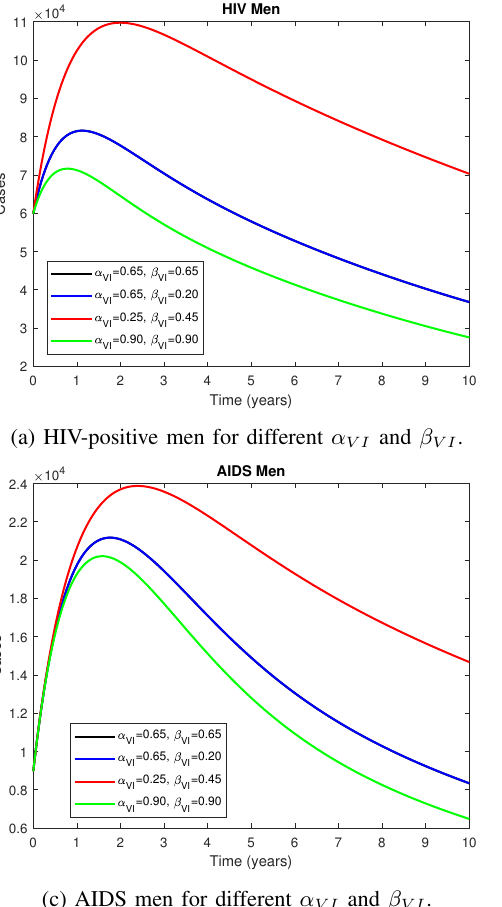
α V I independently is always greater than unity.